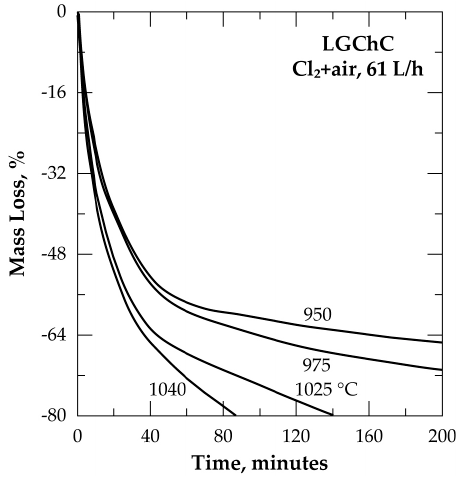
Figure 12. Mass change of the sample versus time for the treatment of LGChC in Cl 2 +air.